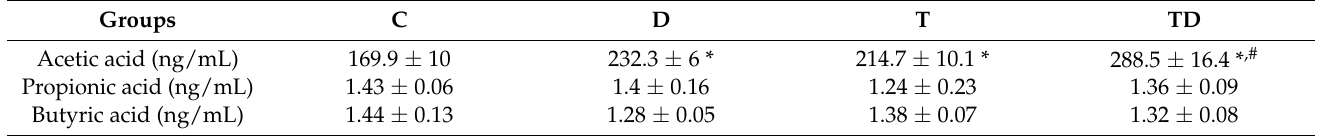
Table 4. Plasma concentrations of short chain fatty acids